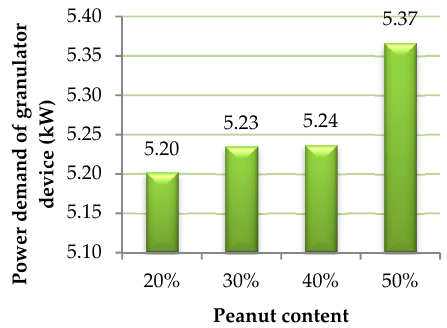
Figure 1. Dependence of granulator demand on power from peanut content in mixture with sponge flour.